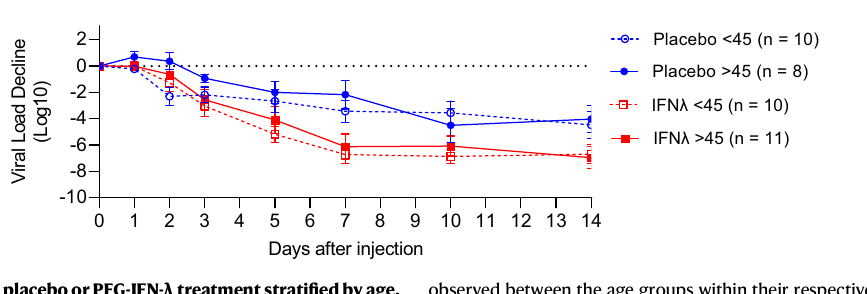
observed between the age groups within their respective treatment groups (Wil- coxon rank sum test). Error bars represent the standard error. Source data are provided as a Source Data fi